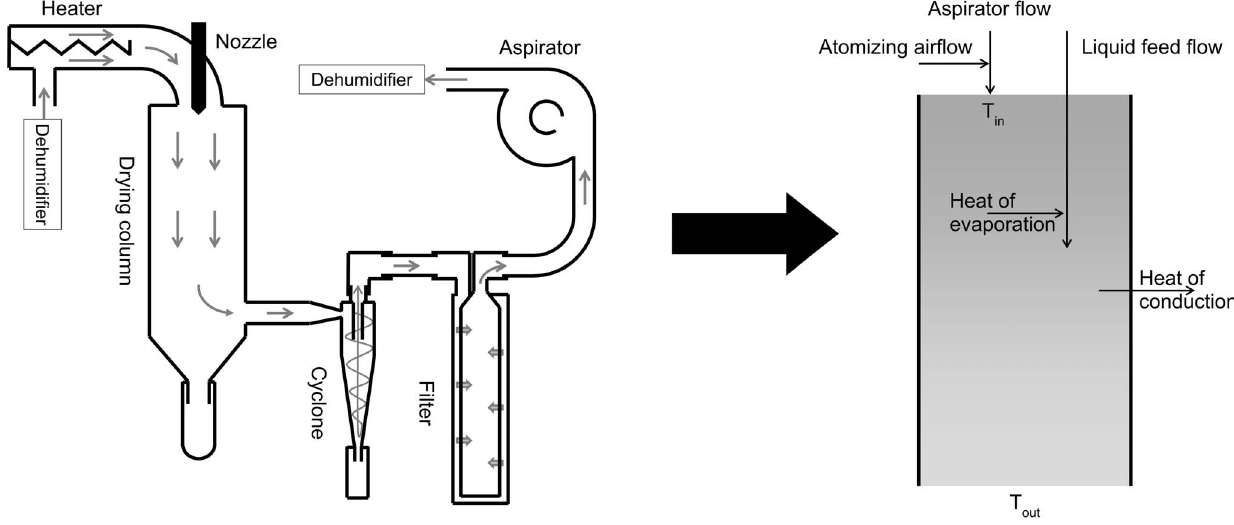
Figure 1. Schematic representation of a spray dryer (left) and the simplified spray dryer model (right). Output variables include but are not restricted to the outlet temperature ( T out ).